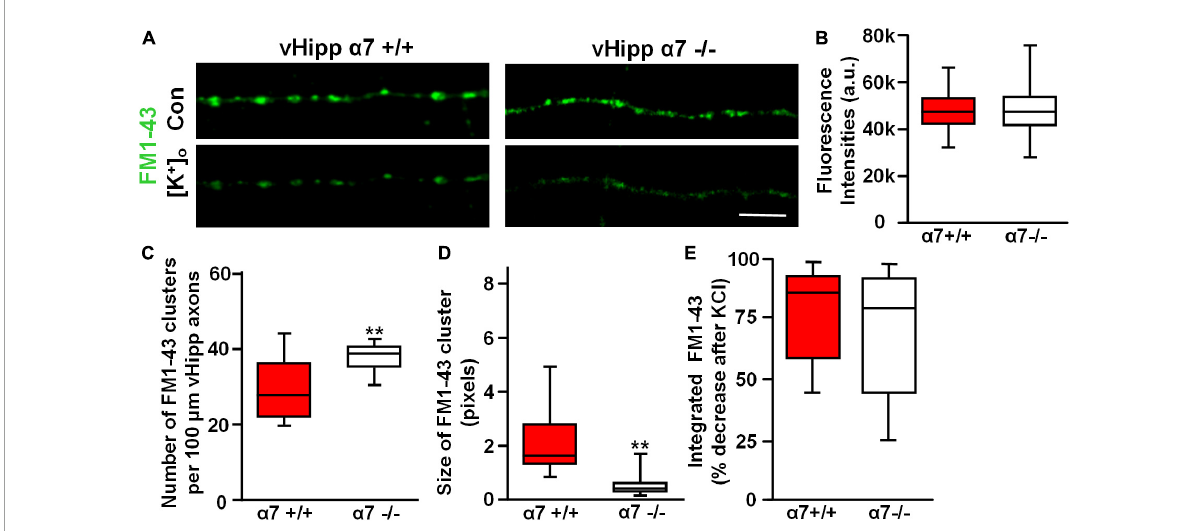
FIGURE8 α 7* nAChRs are required for synaptic vesicles clustering but not for depolarization induced FM1-43 de-staining along ventral hippocampal axons. (A) Micro-explants of vHipp from α 7+/+ or α 7–/– mice were plated for live imaging of axonal projections and assessment of FM1-43 de-staining as an assay of transmitter release. Representative micrographs of WT ( α 7+/+, A , left) and α 7–/– ( A , right) vHipp axons after loading with and washout of FM1-43 (green) under control conditions ( A , top) and after depolarization with elevated extracellular K + ( A , bottom). Responses to depolarizing conditions are equivalent independent of genotype. Scale bar, 10 µ m. (B) Box plot of pooled data from six separate vHipp explants cultures for each group showed equivalent initial FM1-43 staining after K + -dependent depolarization (assayed with total FM1-43 fluorescence intensities) between α 7+/+ ( n = 100; 5) and α 7–/– ( n = 92, 4) vHipp axons. (C,D) Comparison of the number and size of FM1-43 positive puncta along vHipp axons from α 7+/+ ( n = 100; 5) vs. α 7–/– ( n = 92, 4) mice. Box plot of pooled data comparing α 7+/+ vs. α 7–/– in terms of sites of release (FM1-43 puncta) reveals a significantly greater number of clusters ( C , ** p < 0.01) with an equally significant decrease in cluster size ( D , ** p < 0.01; cluster sizes were measured as continuous fluorescent pixels where 1 pixel – 0.267 µ m) of FM1-43 positive puncta. All data were first tested for distribution normality by the test(s) listed in Table 1 prior to statistical analysis. See Table 1 and figure for all n values and statistical tests. (E) Box plots of pooled data on the effect of depolarization (elevated [K] ext ) on FM1-43 destaining from both α 7+/+ ( n = 20,5) and α 7–/– ( n = 20,4) vHipp axons. The efficacy of K + -dependent depolarization on release along vHipp axons was assayed as the percent decrease of overall FM1-43 fluorescence intensity after increased [K] ext . The effect was equivalent regardless of genotype of the